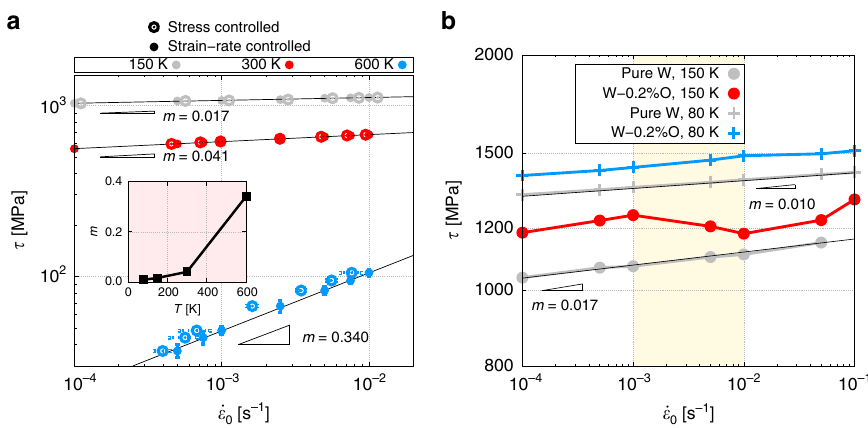
Fig. 3 Negative strain rate sensitivity appears in alloys in speci fi c strain rate-temperature range. a Comparison of the dependence of stress with strain rate (stress-controlled simulations) and vice versa (strain rate-controlled simulations) for a screw dislocation of length 400b in pure W at 150, 300, and 600 K. The results from both approaches are virtually identical. The strain rate sensitivity exponent, m, is displayed in the inset (as the slope in log-log space of each one of the σ - _ ε curves). Error bars for the 150 and 300-K cases are smaller than the size of the markers used in the fi gure. b τ - _ ε 0 curves for the W-0.2%O system at 80 K (no solute motion) and 150 K (dislocation – solute coevolution). Although the alloy system shows the standard behavior at 80 K, inverse SRS can be appreciated between 10 – 3 and 10 – 2 s – 1 at 150 K (shaded region). The pure W curves at 80 and 150 K are added for comparison (with the associated SRS exponents), revealing the hardening owing to the